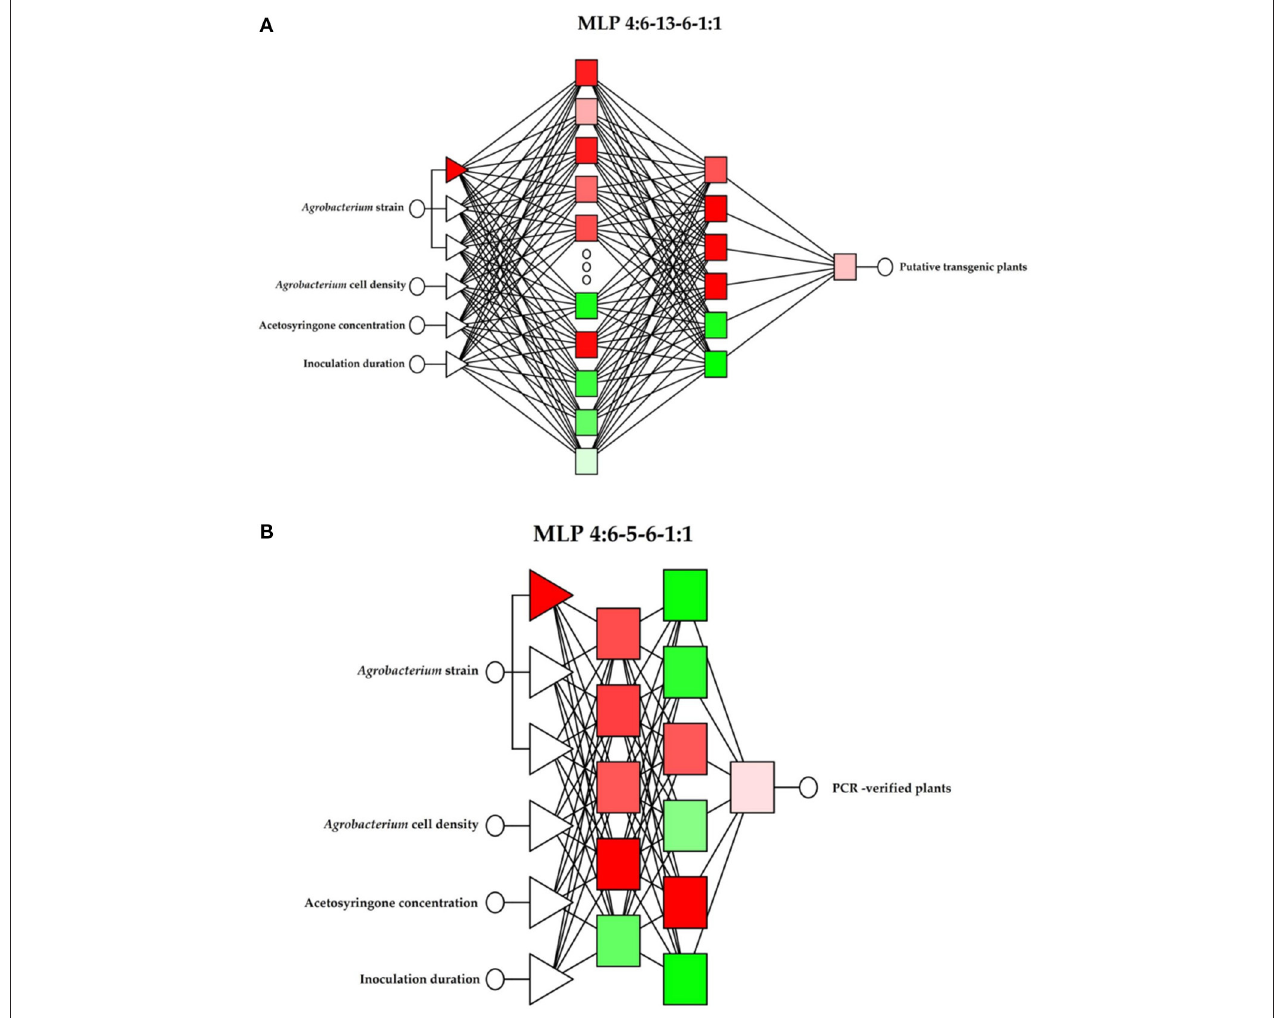
FIGURE 2 | The topology of applied ANN models to predict the percentage of putative and PCR-verified transgenic tobacco. (A) The topology of the ANN with four input factors to predict the percentage of putative transgenic tobacco plants. (B) The topology of the ANN with four input factors to predict the percentage of PCR-verified